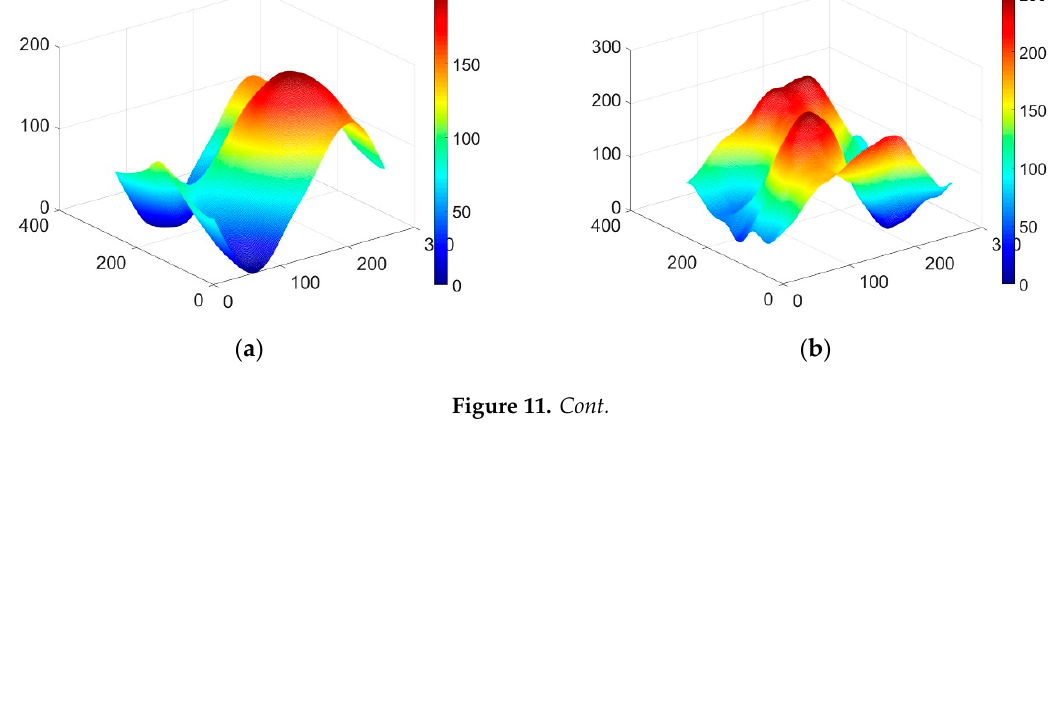
Figure 10. Standard deviation of height versus the perpendicular baseline. ( a ) Corresponding to Figure 7(a) and (d); ( b ) corresponding to Figure 7(b) and (e); and ( c ) corresponding to Figure 7(c) and (f).